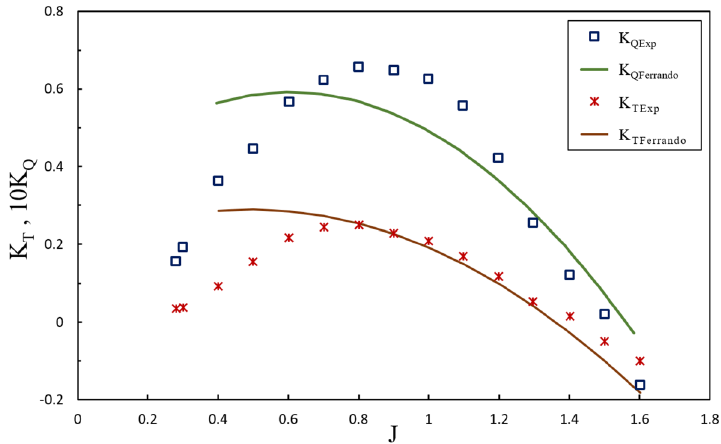
Figure 33. Comparison of Results with Initial Estimates of Design Phase ( I = 0.6, α = 6 ◦